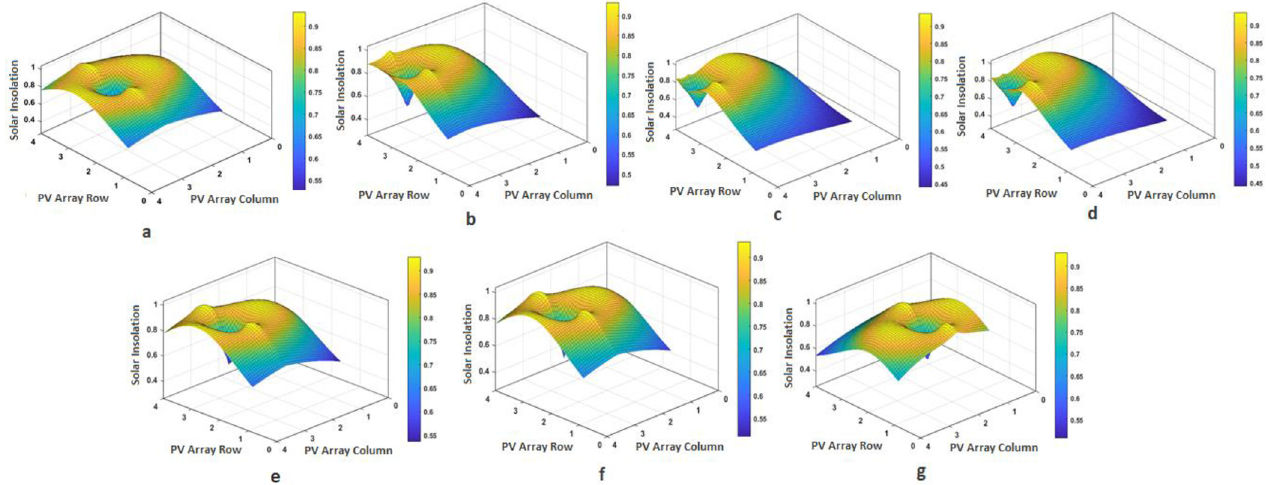
Fig. 6. Partial shading patterns (a) short narrow (SN), (b) short wide (SW), (c) long narrow (LN), (d) long wide (LW), (e) diagonal (D), (f) entire row distribution (ERD),(g) entire column